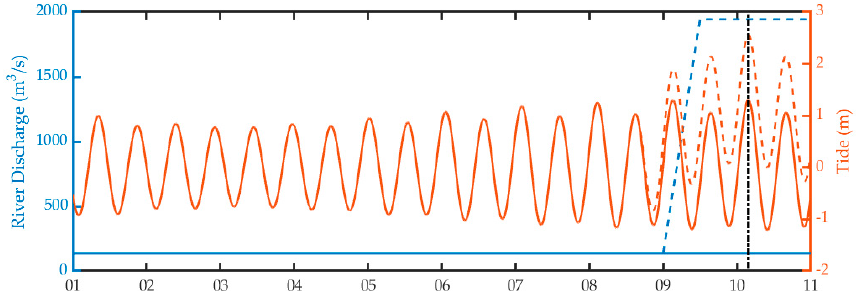
Figure 5. The historical period under the 100-year return period scenario setup. Continuous lines represent the reference conditions, while the dashed line considers the 100-year return period conditions for riverine discharge and extreme sea level.